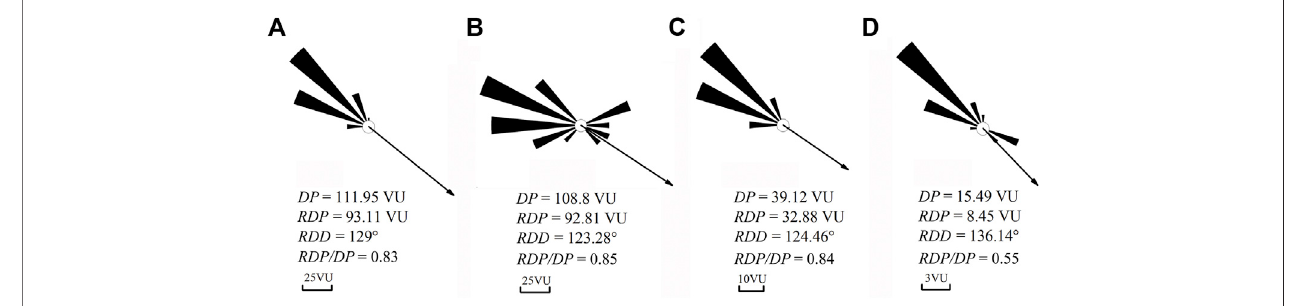
FIGURE 6 | The seasonal variations of drift potential ( DP ) and associated parameters in the areas where linear dunes and barchans coexisted. (A) spring, (B) summer, (C) autumn, and (D) winter. RDP , resultant drift potential; RDD , resultant drift potential; RDP/DP , directional variability. Note that the scales differ among the graphs.